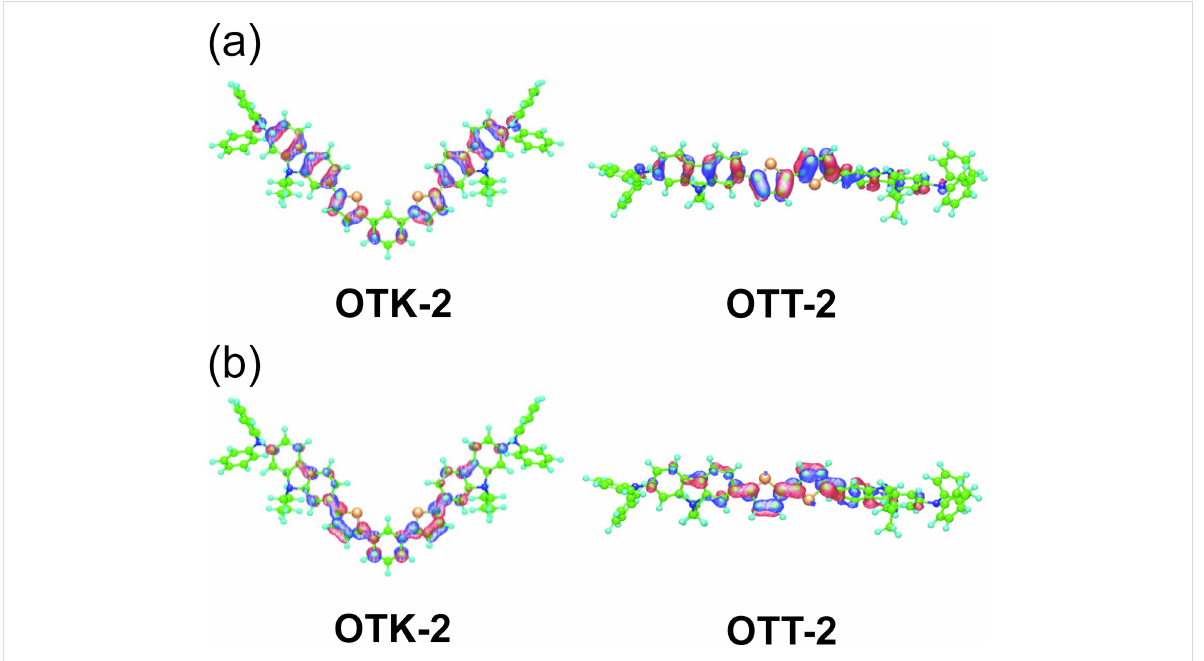
Figure 3: (a) HOMO and (b) LUMO of OTK-2 [33] and OTT-2 derived from MO calculations (PM5, INDO/S method). The red and blue lobes denote the positive and negative signs of the coefficients of the molecular orbitals. The size of each lobe is proportional to the MO coefficient.